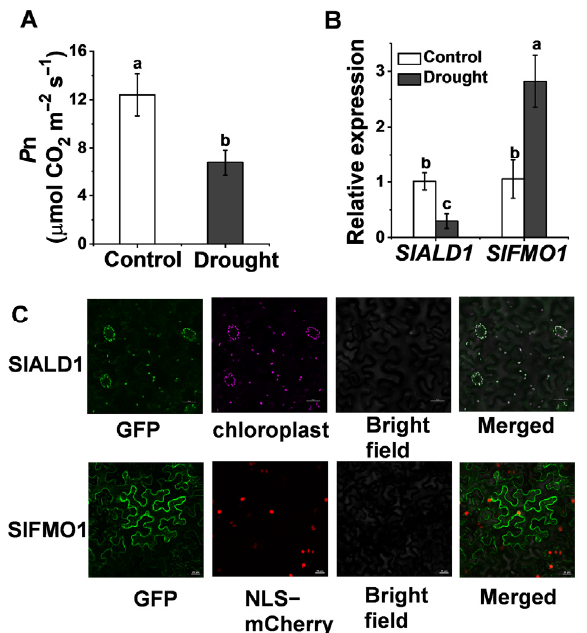
Figure 1. Changes in the transcript levels of tomato pip biosynthetic and hydroxylated modification genes in response to drought stress. ( A ) The net carbon dioxide (CO 2 ) assimilation rate, P n, in wild-type (WT) plants at 48 h after control or drought treatment. ( B ) Relative expression of SlALD1 and SlFMO1 in WT plants leaves at 24 h after control or drought treatment. ( C ) Subcellular localization of SlALD1 and SlFMO1. The tomato SlALD1-GFP and SlFMO1-GFP plasmids were transiently ex- pressed in N. benthamiana leaves. Through confocal microscopy, the GFP, autofluorescence chloroplast, and NLS-mCherry (a marker for nuclear localization) signals were visualized at 48 h after infiltration. Bar = 25 µ m. Different letters (a, b, c) above each bar ( n = 4) represent significant differences ( p <